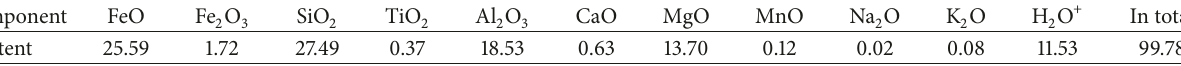
Table 1: Chemical component analysis results of chlorite/%.